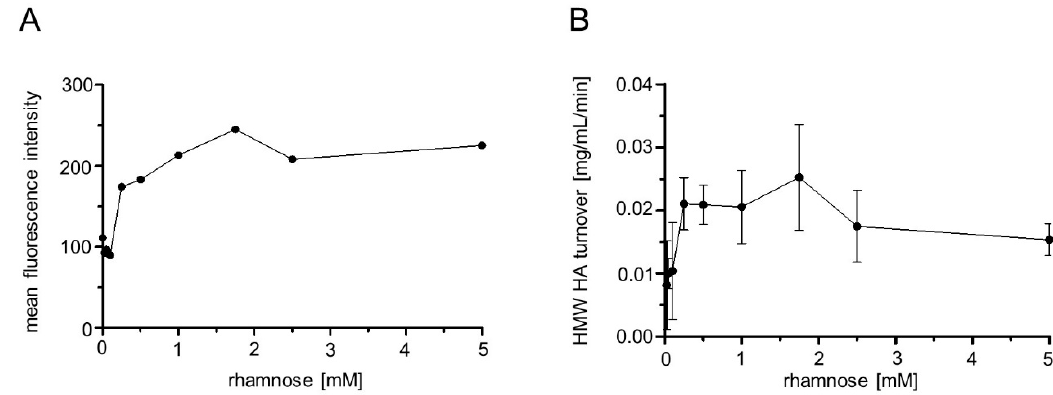
Figure 7. Mean fluorescence (mF) values of immunolabeled E. coli F470 carrying pAIDAI rha -Hyal1 ( A ) and HMW HA turnover ( B ), dependent upon the rhamnose concentration used for protein expression. For flow cytometer analysis, cells were harvested after 16 h induction time and incubated with a primary monoclonal anti-myc antibody and a secondary Dylight 633 conjugated anti-IgG antiserum. 50,000 cells were analyzed per sample. Mean fluorescence intensity is plotted against rhamnose concentration. For HMW HA turnover, cells were harvested and washed with sodium formate buffer (100 mM) pH 3.5. Cell suspension was adjusted to an OD 578 of 10. HA was added (0.11 mg/mL final concentration) and the reaction was run for 1 min at 37 °C. Supernatants were analyzed for residual HMW HA by Stains-all assay. Mean values ± SD (n = 3).